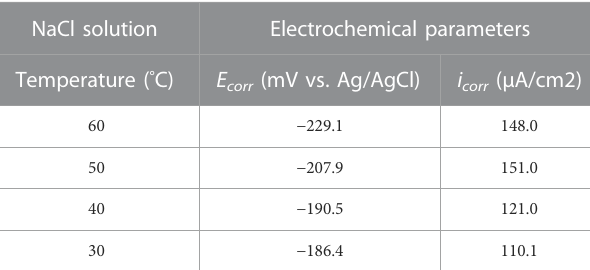
TABLE 2 Electrochemical parameters estimated from Figure